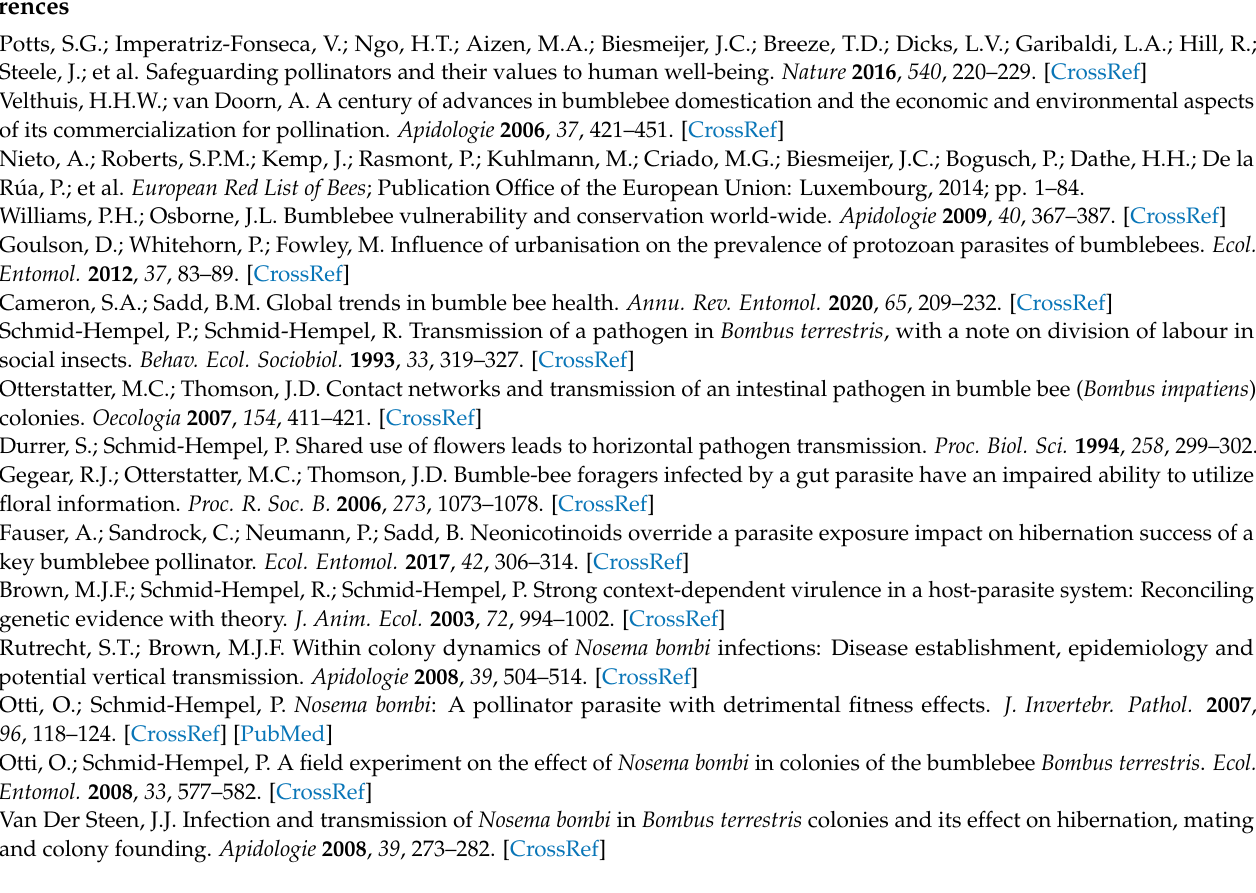
lucorum ; Figure S1: Prevalence in locations with more samplings than 10; Table S2: List of samplings of B. lapidarius